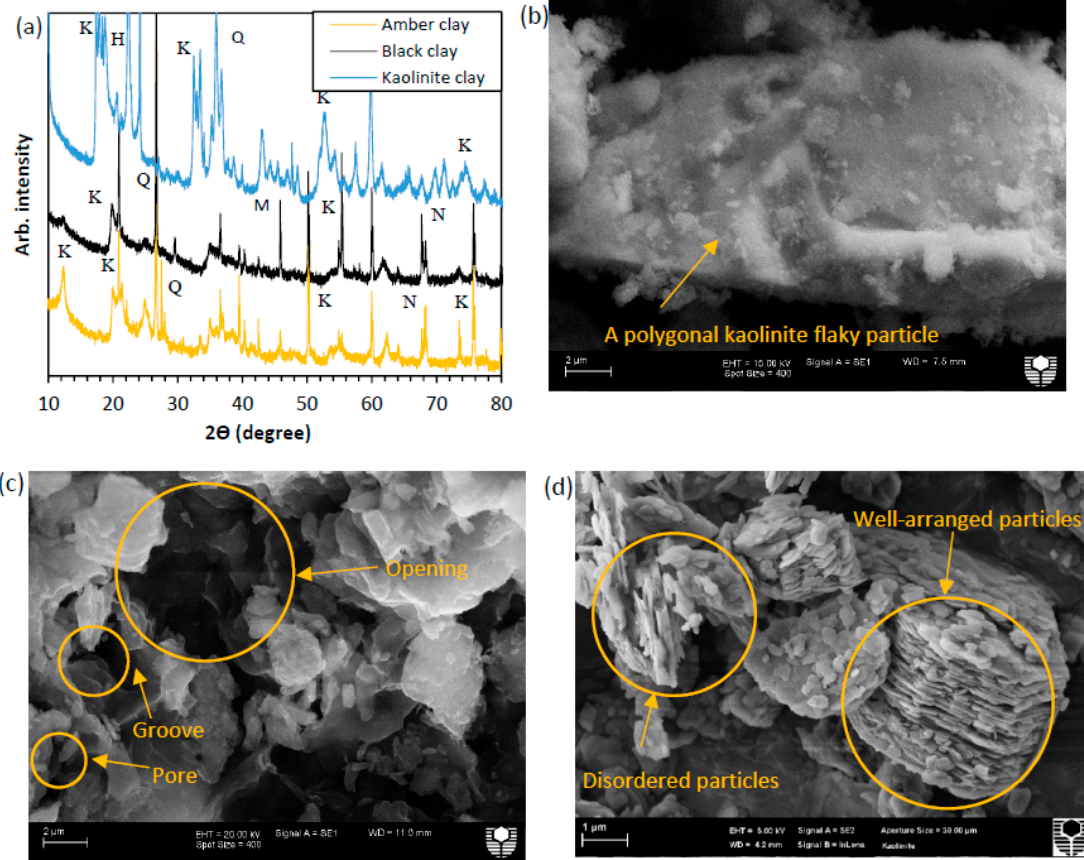
Figure 5. ( a ) X-ray powder di ff raction (XRD) tests and SEM analysis of ( b ) amber clay; ( c ) black clay; Figure 5. (a) X-ray powder diffraction (XRD) tests and SEM analysis of (b) amber clay; (c) black clay; and ( d ) kaolinite and (d) kaolinite clay.